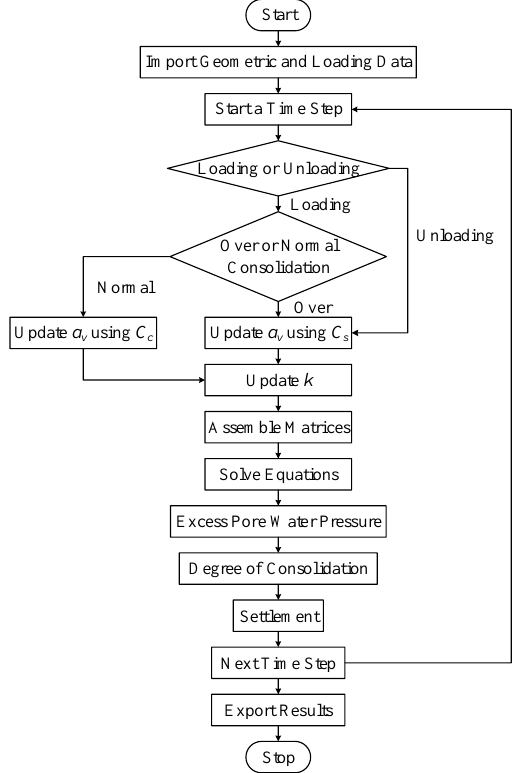
Figure 2. The calculation flow chart based on the finite element method.